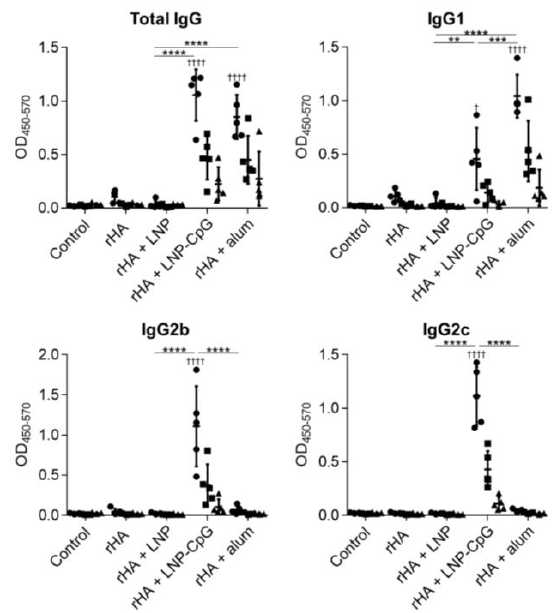
Figure 6. Hemagglutinin (HA)-specific antibody responses in vivo. Mice were subcutaneously immunized with recombinant HA (rHA) alone, rHA plus LNP, rHA plus LNP-CpG, or rHA plus alum on days 0 and 21. On day 28, the levels of rHA-specific total IgG, IgG1, IgG2b, and IgG2c in plasma were evaluated by using ELISA. We used 160- ( ● ), 800- ( ■ ), and 4000- ( ▲ ) fold diluted plasma samples. n = 5. Data are means ± SD. Significant differences were only analyzed in the 160-fold-diluted plasma samples. † p < 0.05 and †††† p < 0.0001 vs. group immunized with rHA alone; ** p < 0.01, *** p < 0.001, and **** p < 0.0001, as indicated by Tukey’s test.